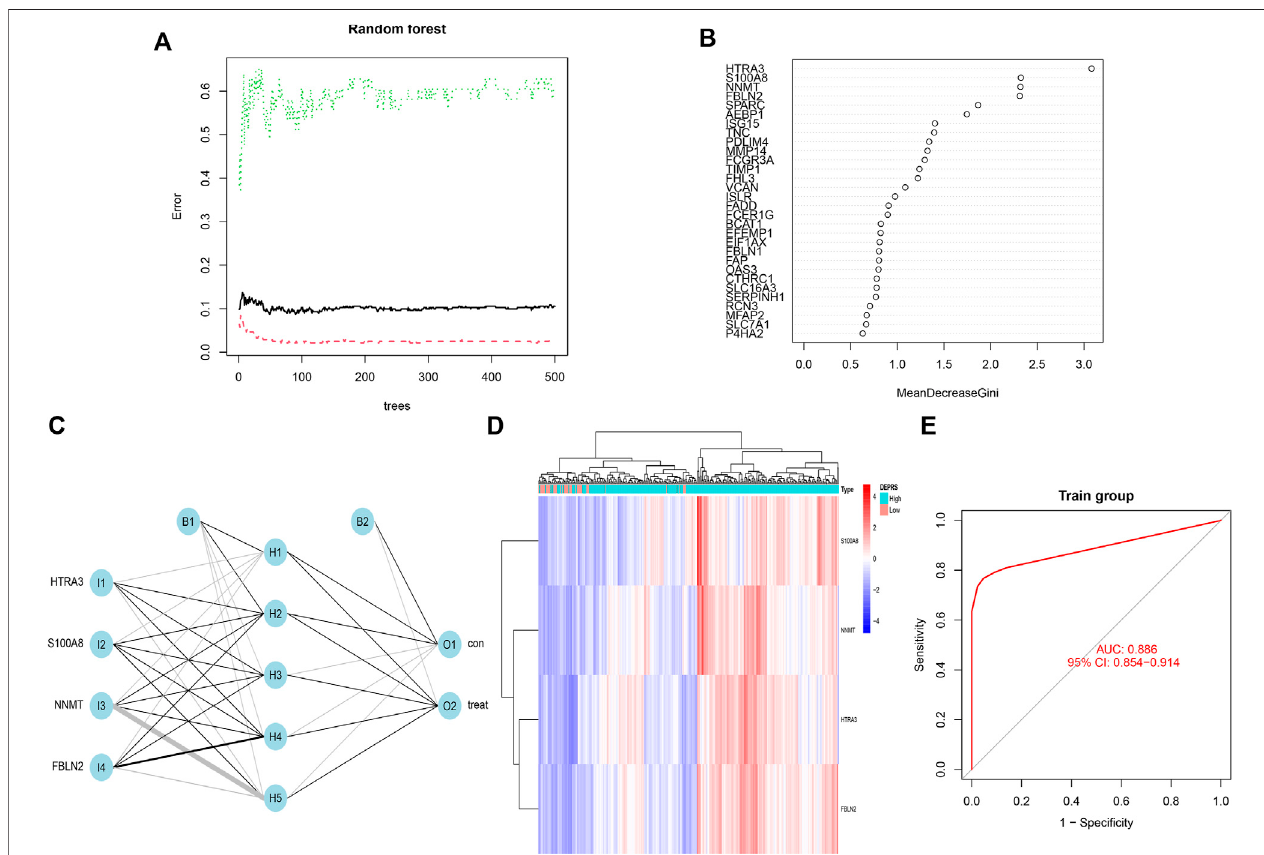
FIGURE8|(A) Relationshipbetweentheerrorrateandnumberofclassi fi cationtrees. (B) Ginicoef fi cientmethodusedtoscreenspeci fi cgenes(IV > 2).Therewere HTRA3, S100A8, NNMT, FBLN2. (C) Results of neural network visualization. (D) A heat map showing differences among the four genes between high DEPRS and low DEPES. Red color indicates positive expression and blue indicates negative expression. (E) The predictive value of the arti fi cial neural network model based on four key genes in immunotherapy ef fi cacy (AUC, 0.886, 95% CI: 0.854 – 0.914).